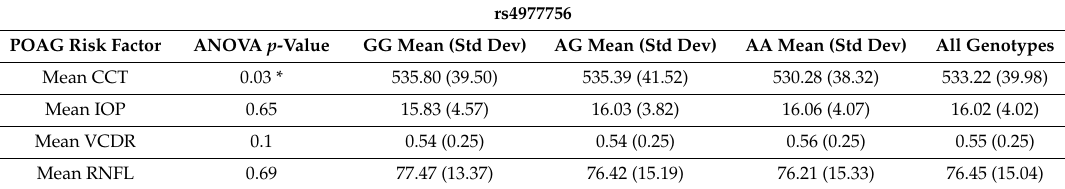
Table 3. Relationship between rs4977756 genotypes and quantitative POAG risk factors. * denotes a statistically significant result ( α = 0.05).